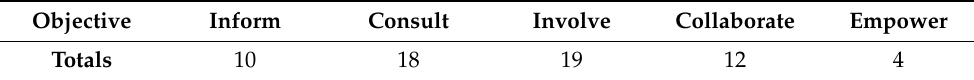
Table 2. Number of mentions of the different SPP categories [18] by the online survey respondents ( n = 28, concerning 25 geoparticipation